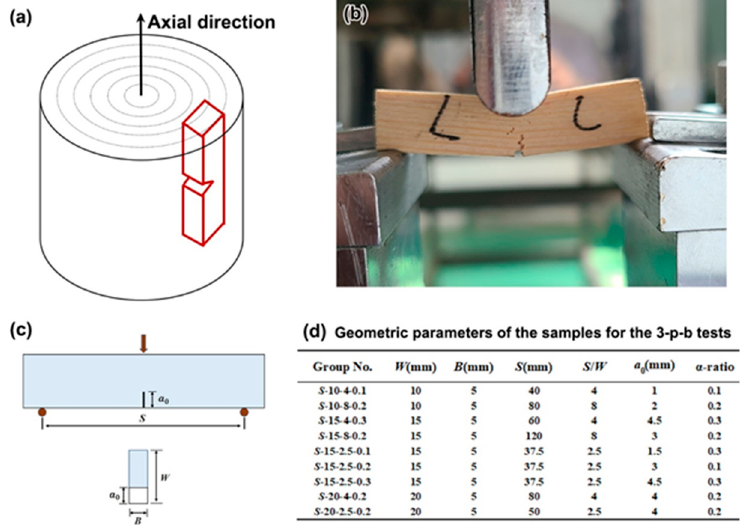
Figure 1. Schematic diagram for the preparation of samples ( a ) and the actual loading device ( b ) for 3-p-b tests, and schematic diagram of the dimension of samples ( c ), together with the geometric parameters (listed in Table) ( d ) for the 3-p-b tests.